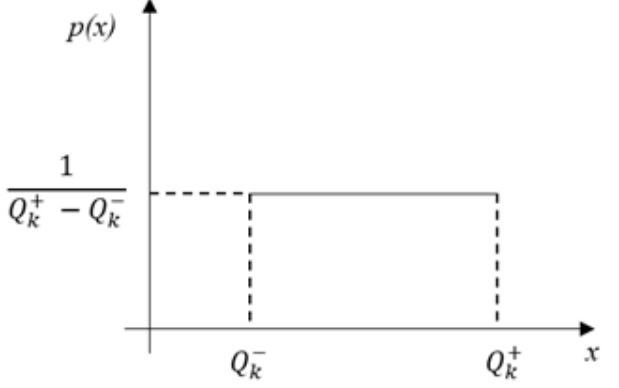
Figure 3. Uniform Probability Density Distribution for Reactive